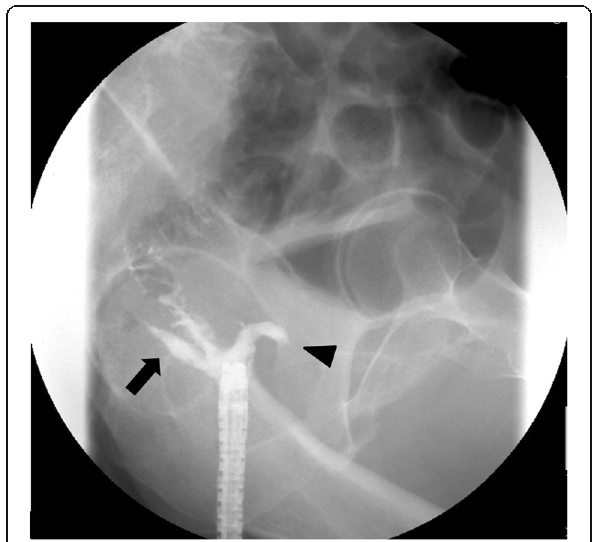
Fig. 3 Fistula formation was observed at the anastomotic site after low anterior resection on contrast radiography. Arrow head and arrow indicate fistulae which go to the anterior and posterior side of the anastomosis, respectively. There was no anastomotic-urethral fistula seen on contrast